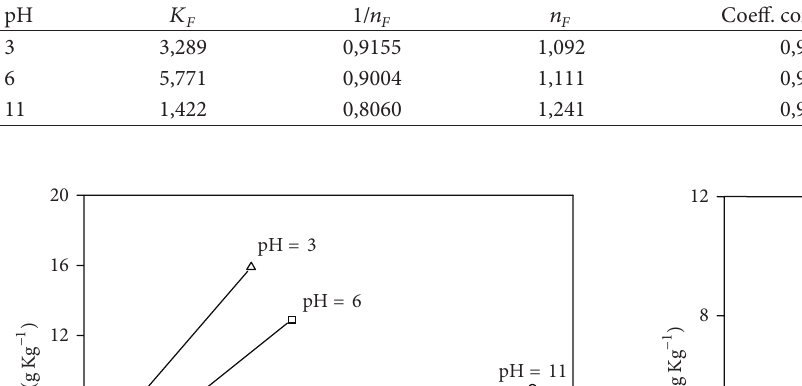
T 2: Parameters of the freundlich isotherm for adsorption of reactive dye by the cellulose-g-CDNMA.